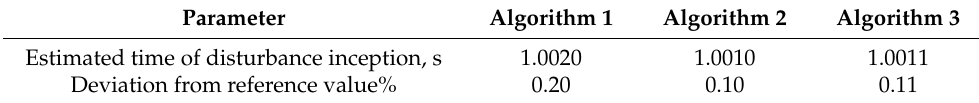
Figure 8. Results of inception time detection for the modeled signal. Table 3. Results of inception time estimation for the modeled